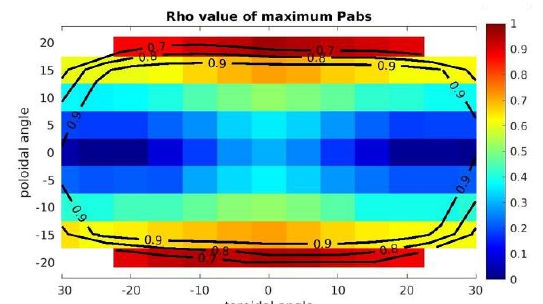
Figure 2: Location of the absorption (in normalized radius depending on the injection angle for WEST shot 55799. The superimposed labeled black contours show the fraction of total absorbed power.